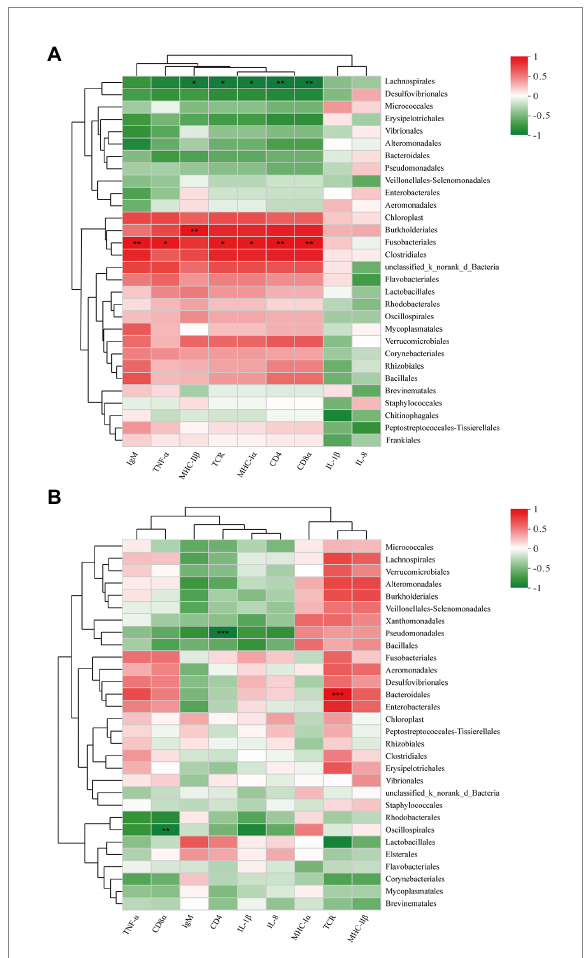
FIGURE 7 Heatmap showing the correlations of immune-related gene expression with the top 30 abundant taxa at the order level in the (A) CTRL35 and FKV35 groups and in the (B) CTRL35, ∆ Sia35H, and ∆ Sia35L groups at 35 dpiv. The horizontal axis represents immune- related gene names, and the vertical axis represents the top 30 abundant taxa. Average-based clustering trees for microbes and genes are shown on the left and top of the plot. The colors in the two-dimensional matrix range from green (negative correlation) to red (positive correlation). The color density represents the magnitude of the correlation coefficient value. The correlation was statistically significant when r > 0.8 at p < 0.05 (*), p < 0.01 (**), or p < 0.001